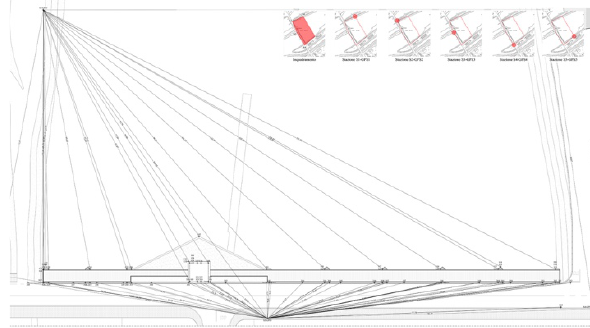
Figure 2. Traditional survey through Total Stations